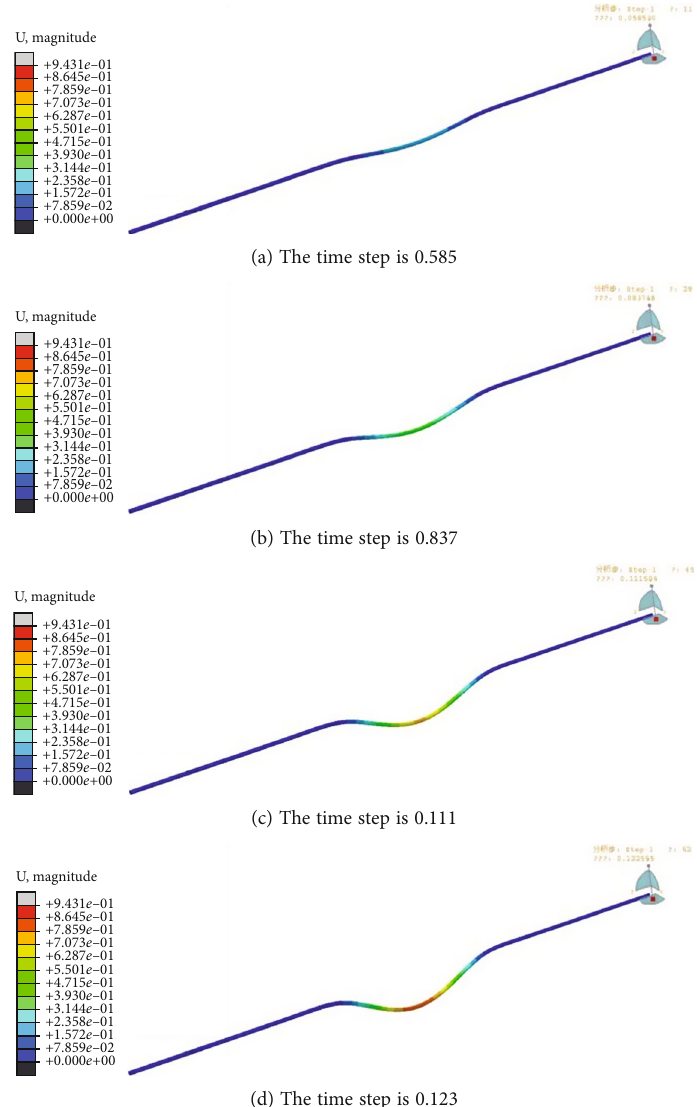
Figure 29: The pipeline deformation at di ff erent time